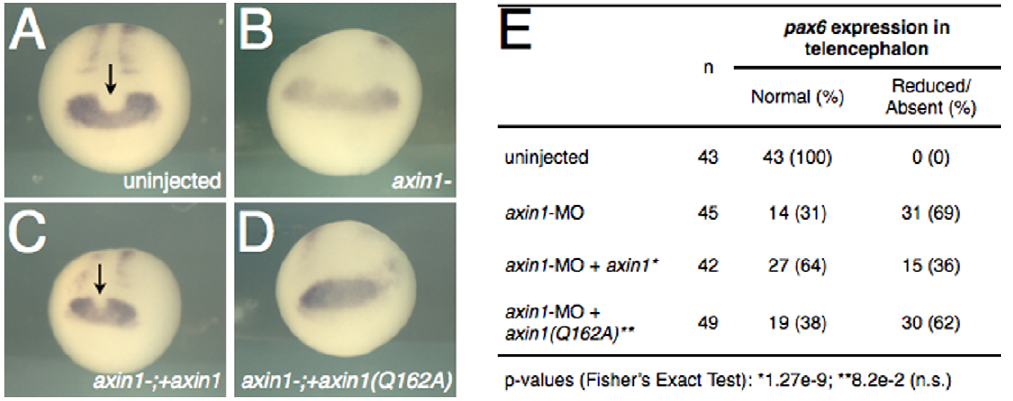
Figure 6. axin1 but not axin1(Q162A) rescues telencephalic defects in Axin-depleted embryos. ( A–D ) Representative examples of pax6 expression in control and Axin1-depleted Xenopus embryos. Arrows indicate the presumptive telencephalon region of the eye field, visible as a narrowed medial notch in the area of pax6 expression. ( A ) Control uninjected stage 20 embryo, ( B ) Axin1-depleted embryo (20 ng axin1 -MO), ( C ) MO injected embryo coinjected with 60 pg axin1 mRNA, ( D ) MO injected embryo coinjected with 60 pg axin1(Q162A) mRNA. ( E ) Summary table of pax6 expression data.